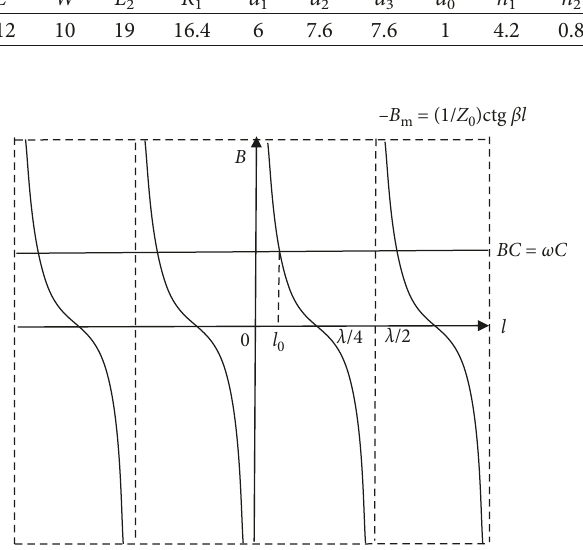
Figure 2: Solution to (1) for the resonant frequencies of the coaxial cavity.